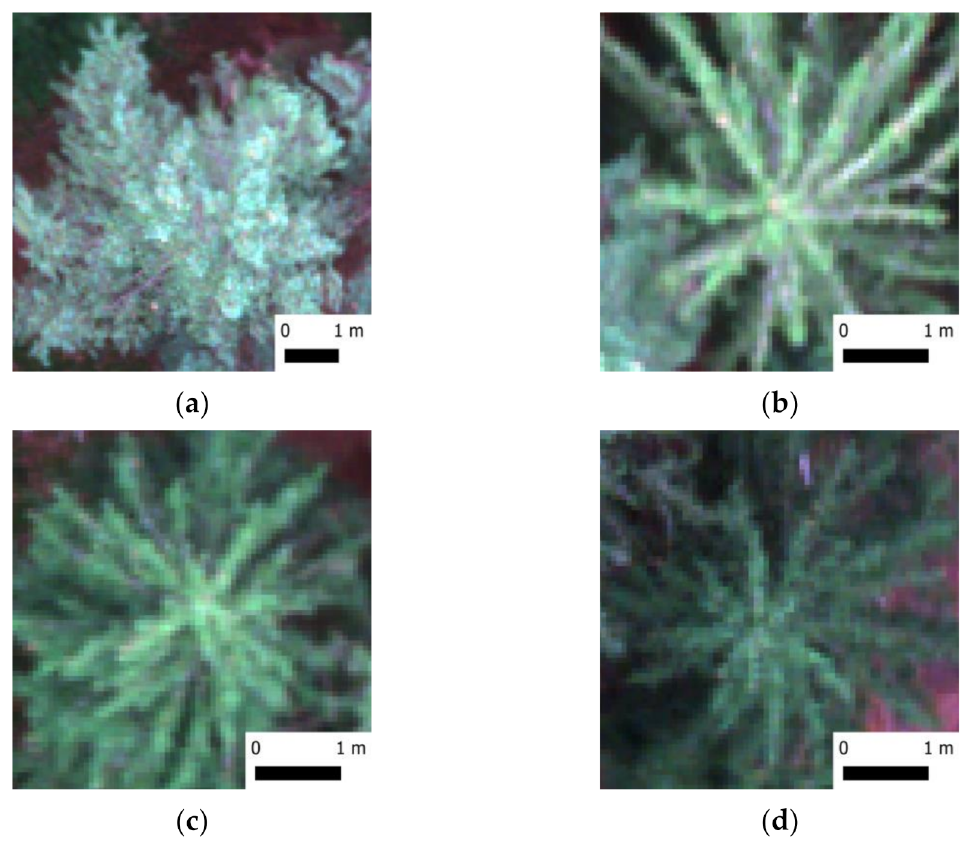
Figure 2. Disturbance classes used in the study: ( a ) pine; ( b ) sbbd—damaged spruce tree (longer infested spruce tree when needles turn to yellow, light green needles dropped, bark flaked away by woodpeckers); ( c ) sbbg—spruce tree under green attack (needles green or light green, resin ducts present); ( d ) sh—live and not infested spruce tree (needles